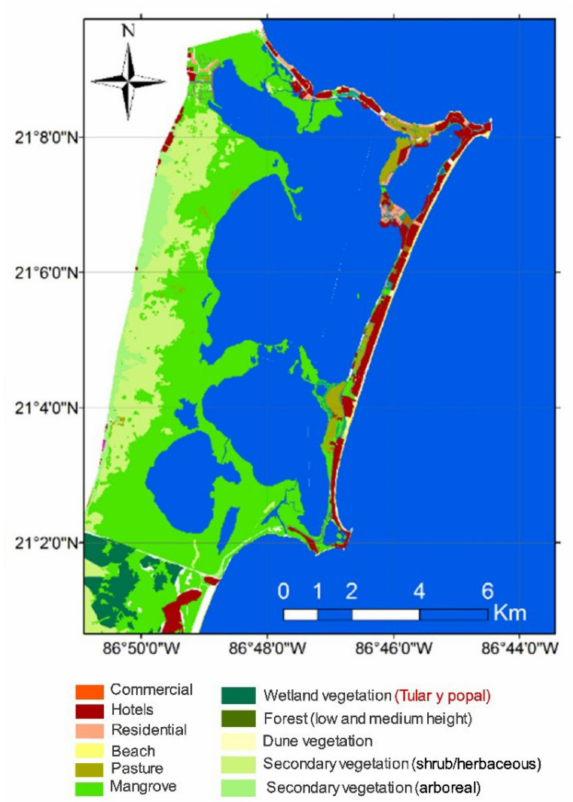
Figure 7. Land use, Cancun 2007 [35]. Intense urbanization all along the barrier rigidized the coast and facilitated the loss of beach